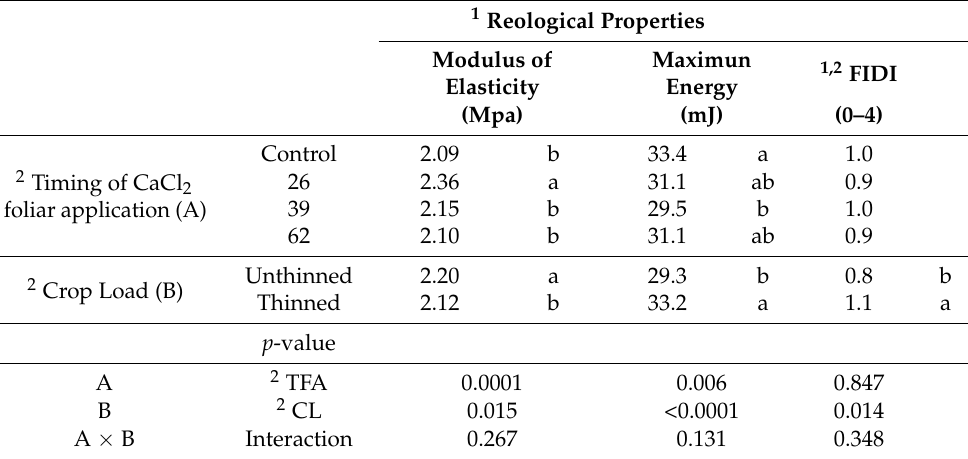
1 Means of 20 fruits/replicate. Different letters in the same column indicate significant differences between the timing of CaCl 2 foliar applications (A) based on Tukey’s test ( p ≤ 0.05) or between crop load levels (B) based on